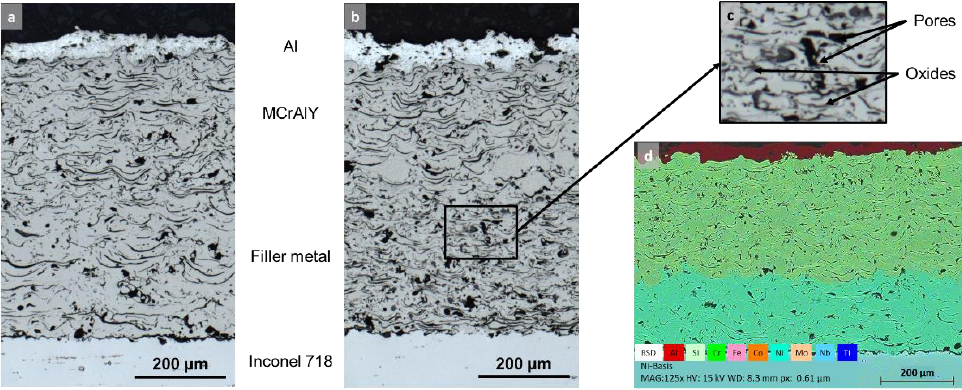
Figure 5. Optical micrographs and EDX data from cross sections of as-sprayed samples: ( a ) coarse powder, ( b ) fine powder, ( c ) fine powder (enlargement), ( d ) element distribution (EDX)